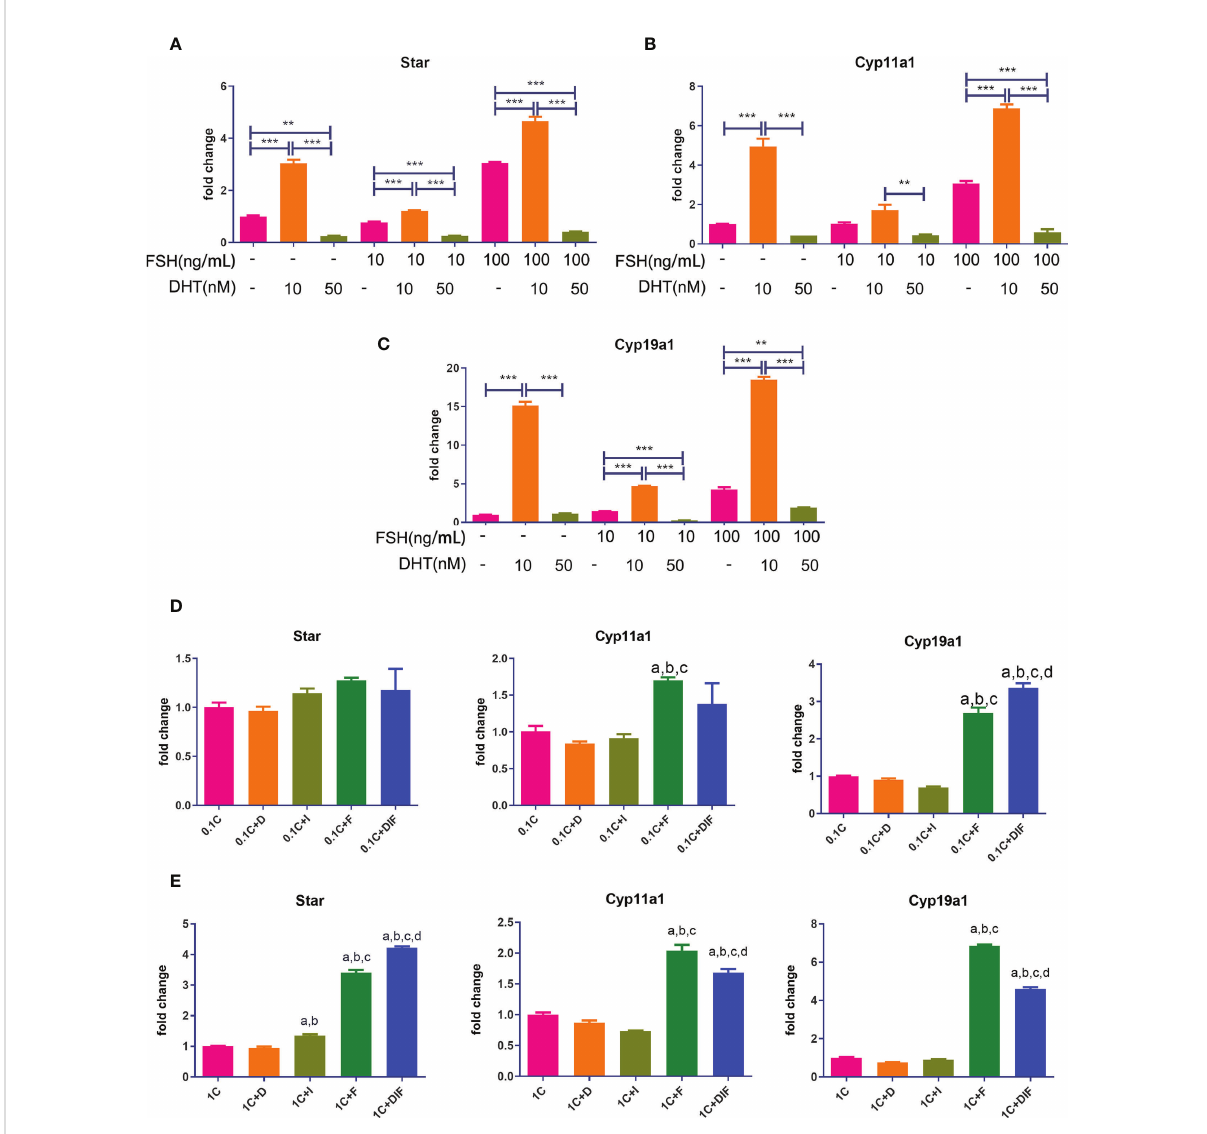
FIGURE 7 Androgen-IGF1-FSH synergistic effect on promoting the expression of steroid hormone synthase and the in fl uence of glucocorticoids on this effect. KGN cells were treated with solvent or low-dose (10 nM) and high-dose (50 nM) DHT in the presence of different doses of FSH for 24 h mRNA expressions of Star (A) , Cyp11a1 (B) , and Cyp19a1 (C) were determined by qPCR. n = 3; one-way ANOVA. KGN cells were treated with low-dose (D) and high-dose (E) CORT for 24 h and then treated with and without DHT, IGF1, or FSH alone and combined DHT-IGF1-FSH, respectively, for 48 h mRNA expressions of Star , Cyp11a1 , and Cyp19a1 were determined by qPCR. n = 3; one-way ANOVA. 1C: 1 µM CORT; 1C +D: 1 µM CORT + 10 nM DHT; 1C+I: 1 µM CORT + 100 ng/ml IGF1; 1C+F: 1 µM CORT + 20 ng/ml FSH; a: P < 0.05 compared to “ 1C ” group; b: P < 0.05 compared to “ 1C+D ” group; c: P < 0.05 compared to “ 1C+I ” group; d: P < 0.05 compared to “ 1C+F ” group.